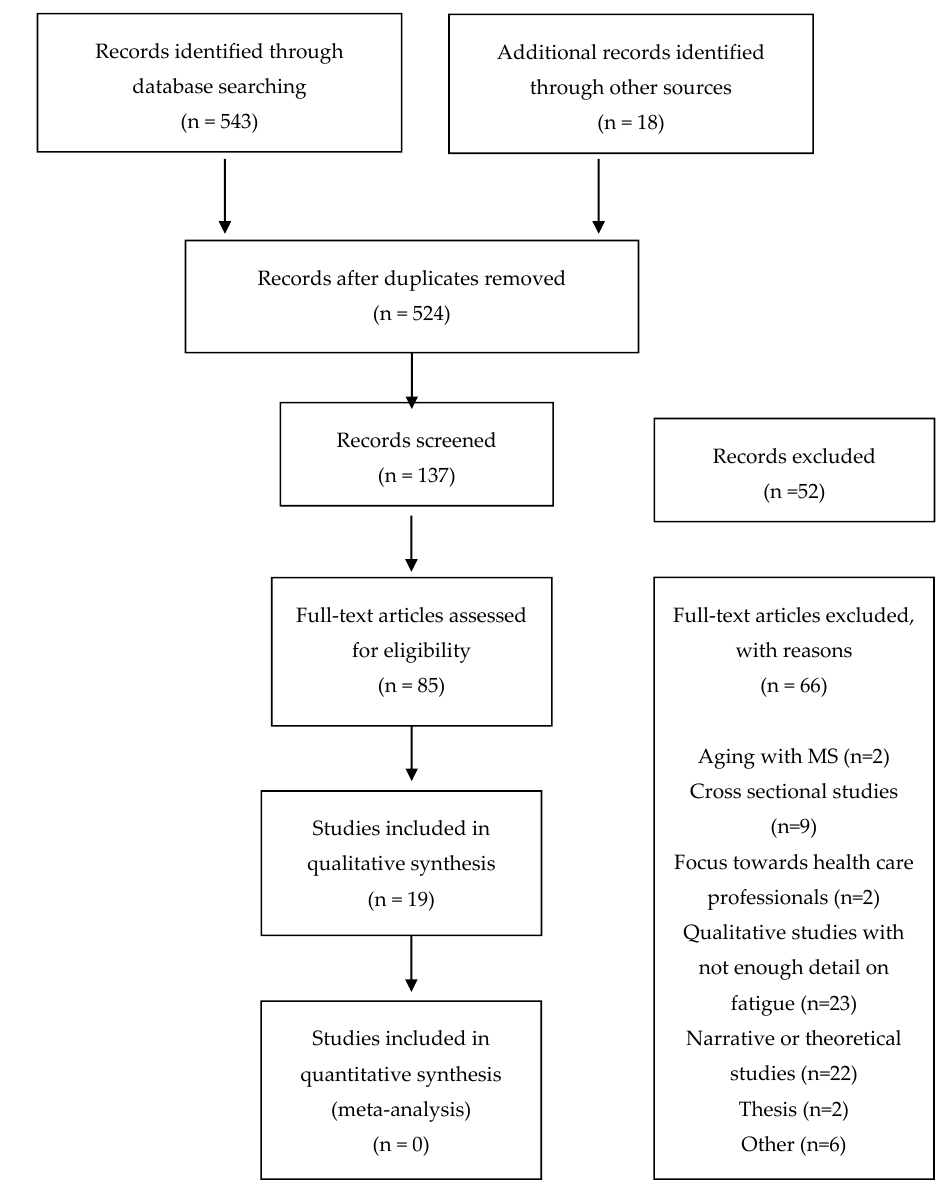
Figure 1. PRISMA diagram.